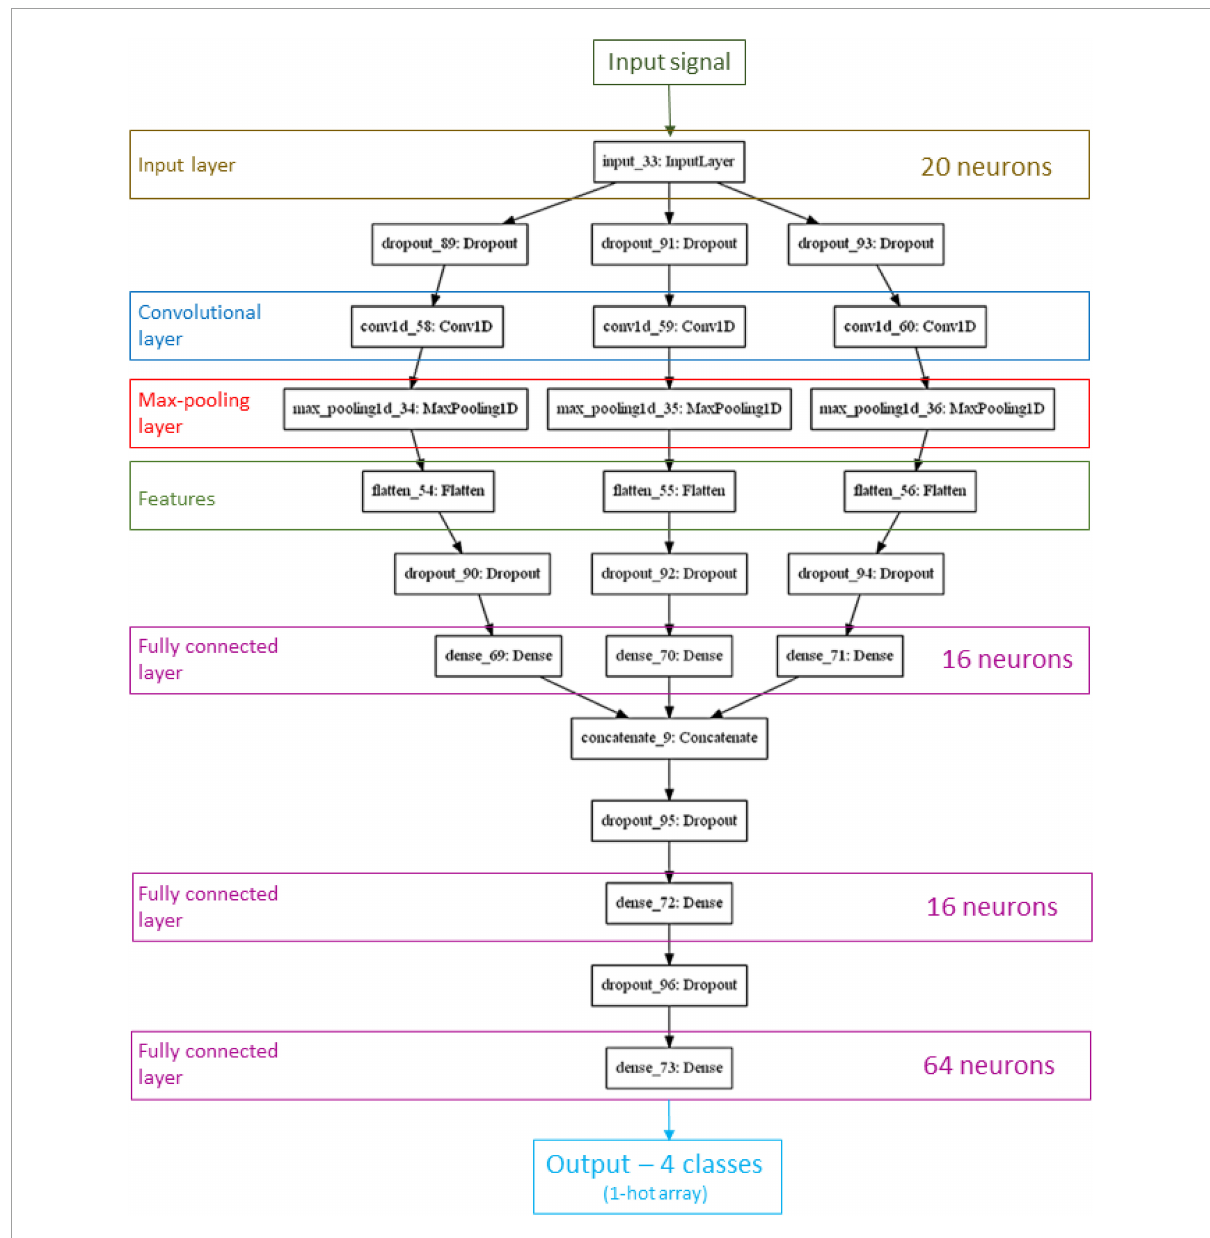
FIGURE3 The convolutional neural network (CNN) architecture that achieved the best